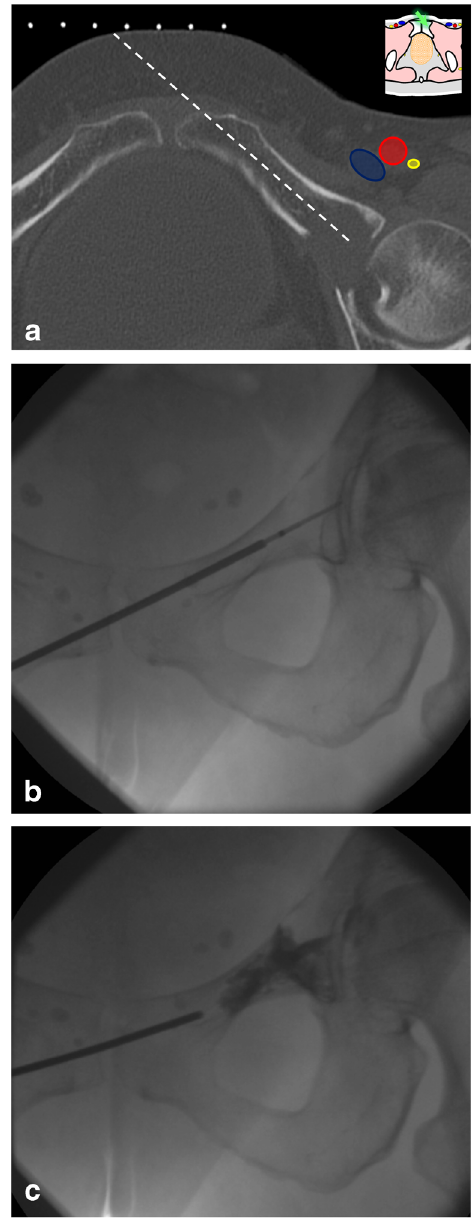
Fig. 19 A 66-year-old woman presenting with a painful superior pubic ramus lung carcinoma metastasis. A thermal ablation and cementoplasty was performed for pain control and bone support. a An approach through the pubic symphysis and superior pubic ramus ( dashed line ) was chosen because the femoral vessels and nerve prevented direct access. b AP fluoroscopy image shows the radiofrequency ablation electrode inserted coaxially within the lesion. c AP fluoroscopy image shows the cementoplasty performed through the coaxial